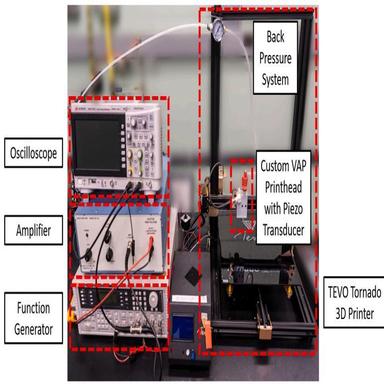
An image of the vibration-assisted printing system with the key components labeled.